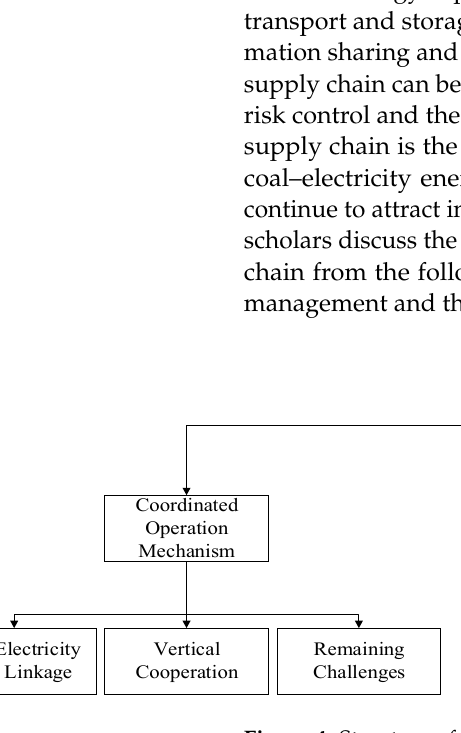
Figure 4. Structure of Study on Energy Supply Chain.